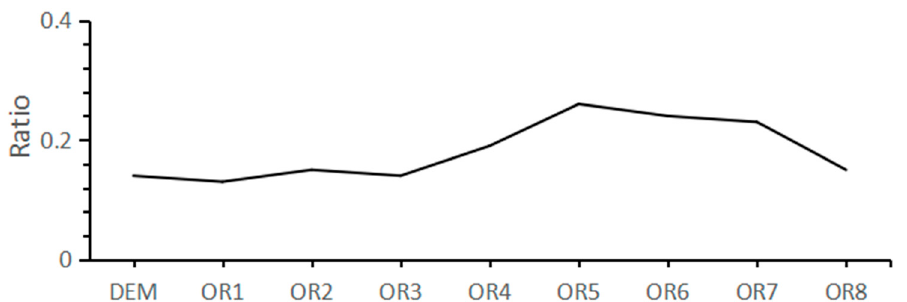
Figure 6. Variation pattern of ratios with terrain scales.